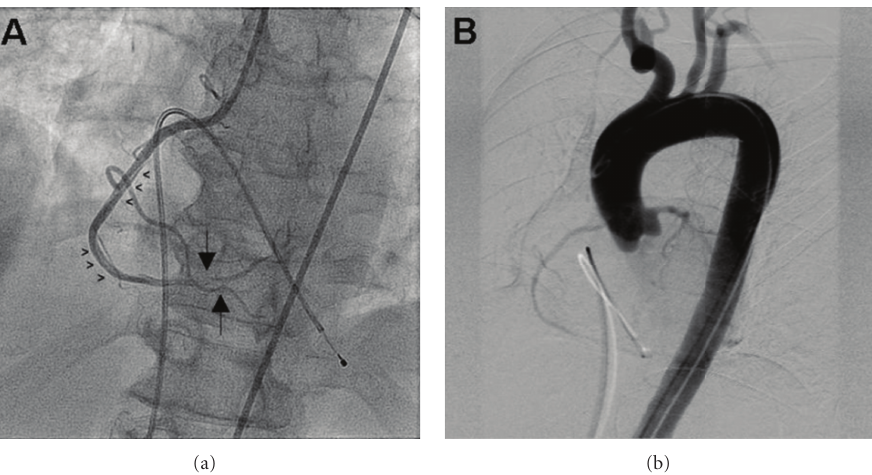
Figure 2: (a) Selective angiography of the right coronary artery (RCA) demonstrating a long dissection extending from the mid-to-distal portions (arrowheads), and thrombotic subtotal occlusion of the posterior descending and posterolateral left ventricular arteries (large arrows). (b) Digitally subtracted aortography showing no evidence of ascending aortic dissection.